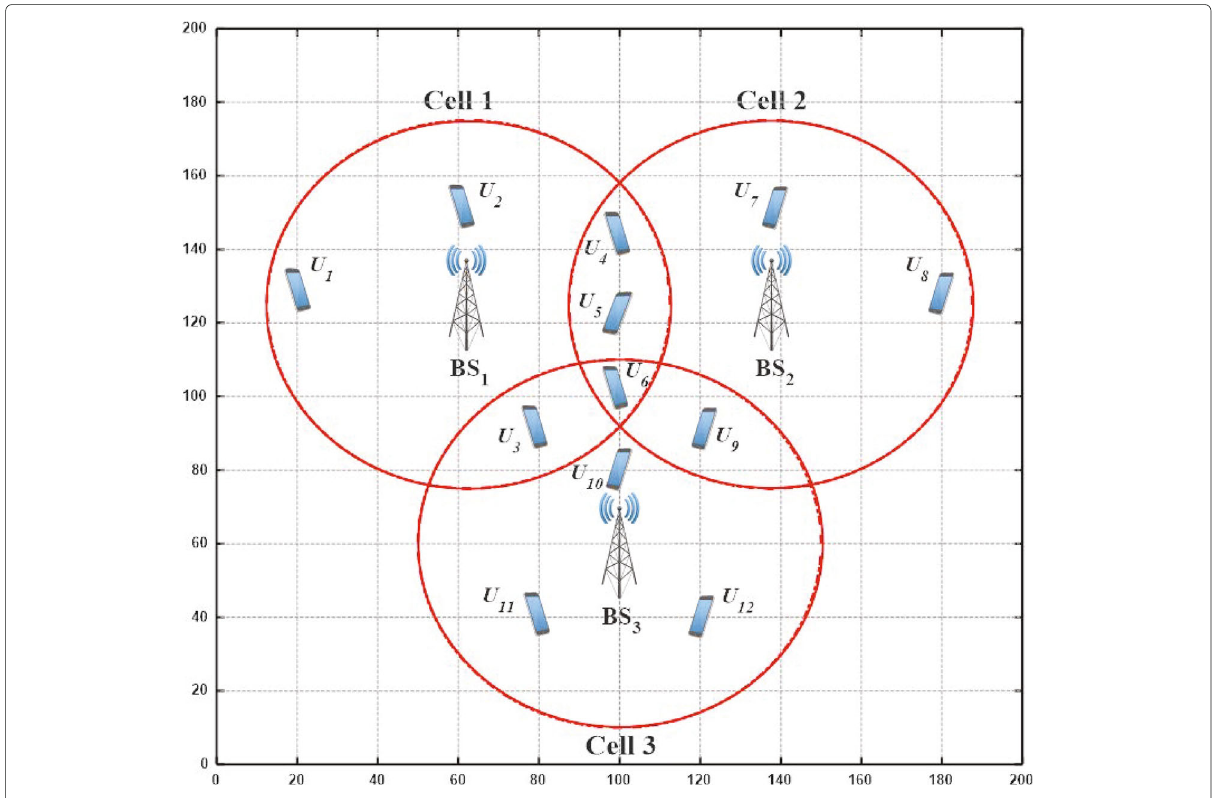
Fig. 2 Simulated network topology